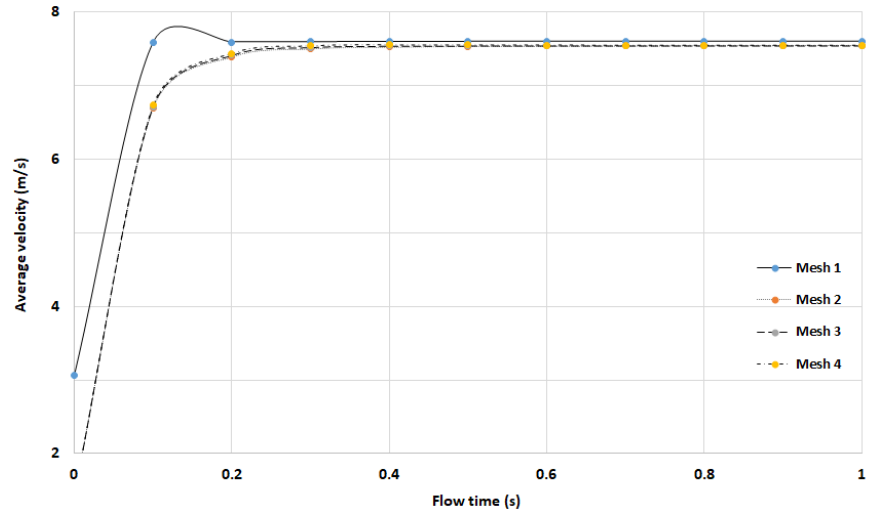
Figure 3. Average velocity at the exit of the blade channel for four different meshes in model